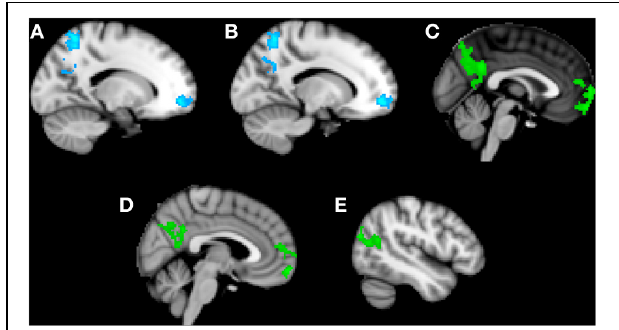
FIGURE 3 | Clusters of activity significantly correlated with trait or state anxiety in the Friend condition. Blue areas indicate a negative correlation with trait anxiety; green areas indicate a positive correlation with state anxiety. (A) Cluster 1, peak activation in left superior parietal lobule. (B) Cluster 2, peak activation in left frontal medial cortex. (C) Cluster 3, peak activation in posterior cingulate cortex. (D) Cluster 4, peak activation in frontal pole. (E) Cluster 5, peak activation in left superior lateral occipital